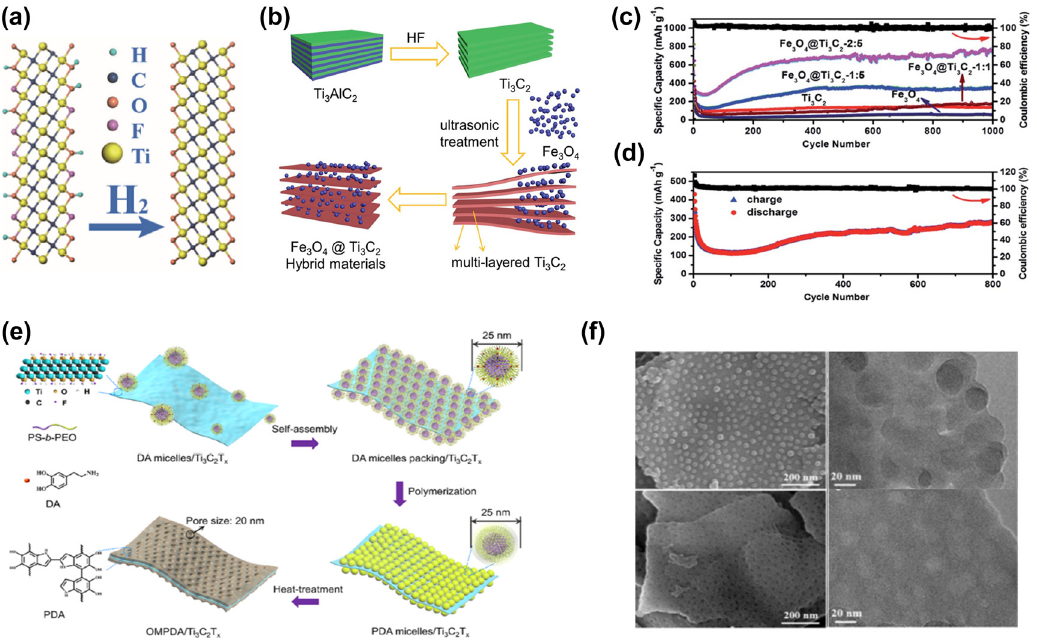
C T composites. 3 2 x . Reproduced with permission [80]. Copyright 2018, Elsevier B.V. (b) Schematic showing the 2 O @Ti C hybrids. (c) Long cycling performance of Ti 3 4 3 2 O @Ti C -2:5 at 5C. Reproduced with permission [81]. Copyright 2018, The Royal Society of Chemistry. (e) 3 4 3 2